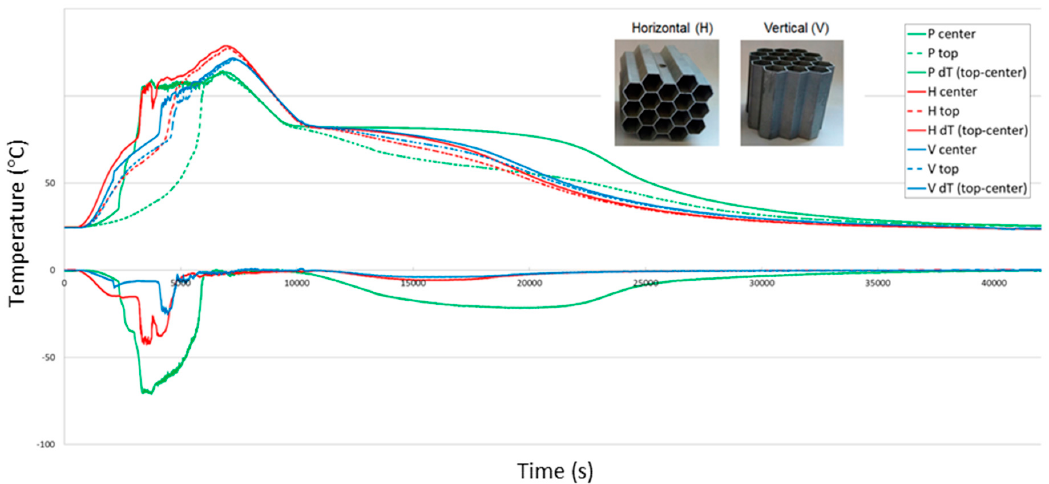
Figure 7. Temperature courses and their derivatives as a function of time during the regular working cycle (charging and discharging): P (pure para ffi n), H (horizontal) location of honeycomb insert, V cycle (charging and discharging): P (pure paraffin), H (horizontal) location of honeycomb insert, V (vertical) location of honeycomb insert. (vertical) location of honeycomb